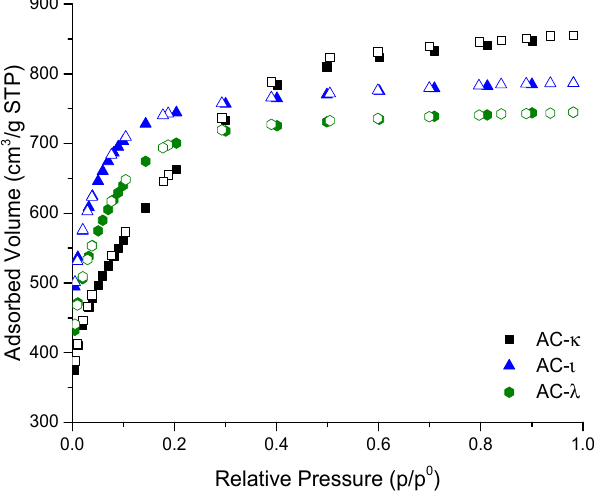
Figure 2. N 2 adsorption (full symbols) and desorption (empty symbols) isotherms for activated carbons at 77K.